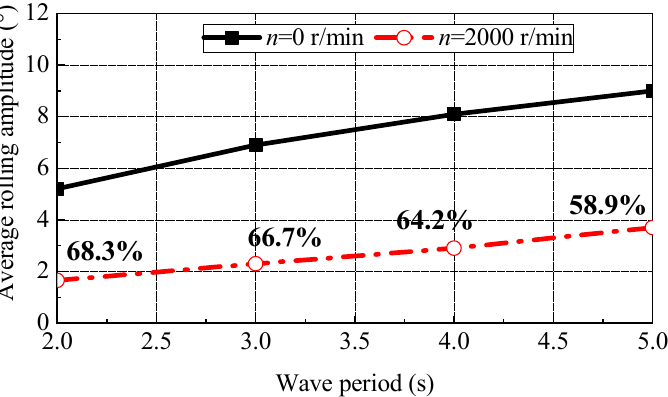
Figure 14. Average roll amplitude of the ship and average anti-roll rate for varying wave periods.